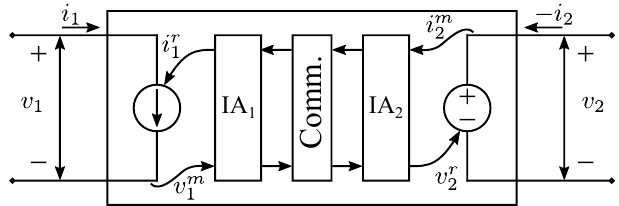
Figure 2. Generic GD-HiL/GD-RTS interface model represented as a two-port